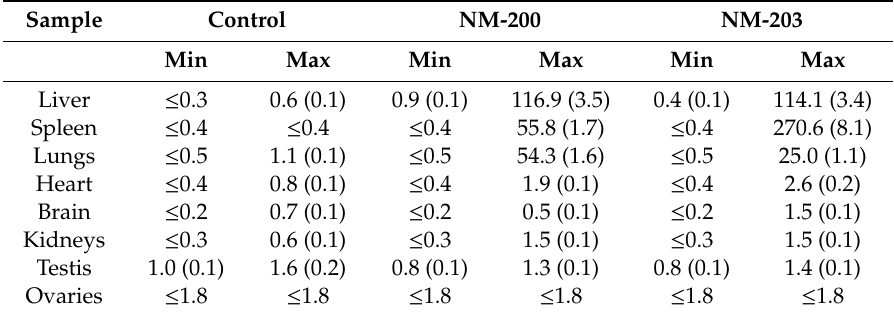
Table 4. Total Si concentration range measured in rat tissues after IV single dose. Results are expressed as µ g Si g − 1 . Measurement errors are expressed as standard deviation in brackets.